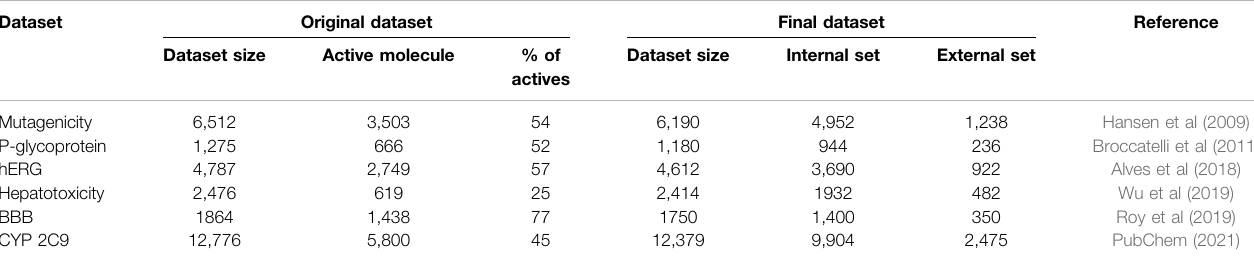
TABLE 1 | Summary of the applied